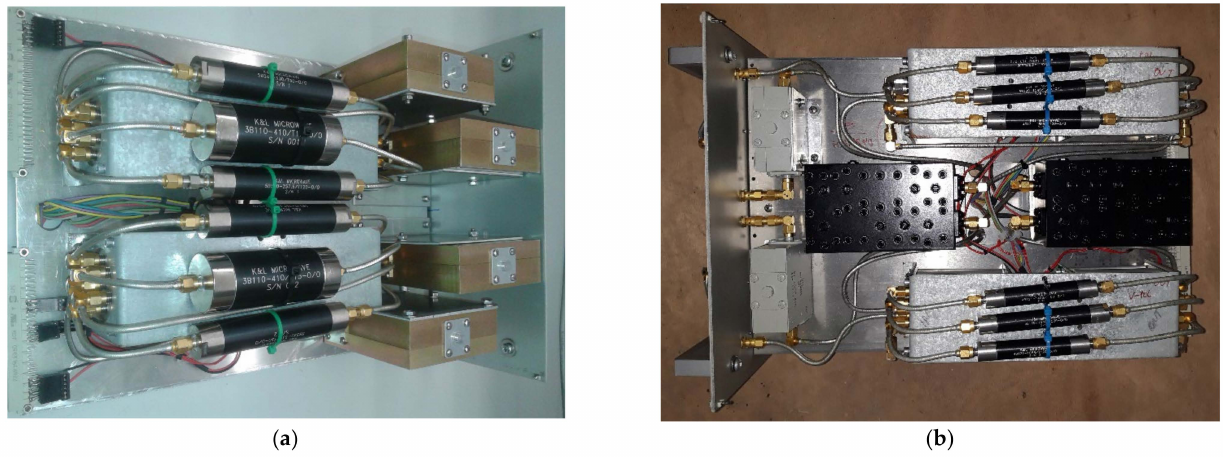
Figure 5. ( a ) P-band filter selector block; ( b ) L-band filter selector